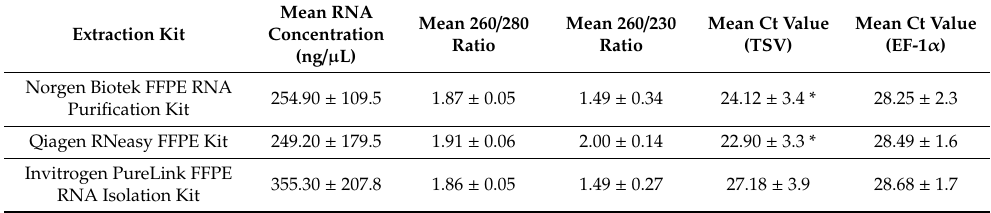
Table 4. A comparison of quantity, quality and Ct (cycle threshold) values of total RNA isolated with the three RNA extraction kits. The table shows RNA concentrations (ng / µ L), 260 / 280 and 260 / 230 values and the Ct values for TSV and the elongation factor 1- α ( EF-1 α ) gene obtained by RT-qPCR. The mean value and standard deviation in each category are shown. An asterisk (*) indicates a statistically significant di ff erence ( p < 0.05) between the values of a particular category (mean RNA concentration, mean 260 / 280, mean 260 / 230, mean Ct for TSV or mean Ct value for EF-1 α ) obtained with the three RNA extraction kits.